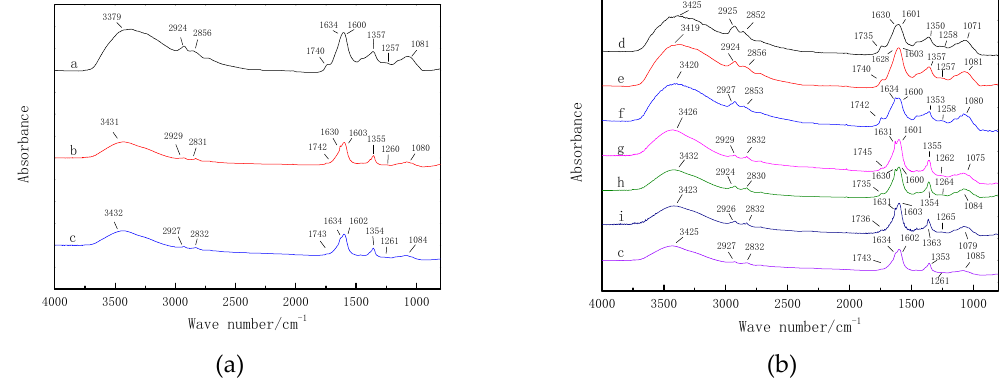
Figure 8. Infrared spectra of Chinese wolfberry fruits under ion wind and without ion wind. ( a ) Ionic wind and without ionic wind; ( b ) different needle spacing. Note: a. Ionic wind; b. Without ionic wind; c. Control; d. 2 cm; e. 4 cm; f. 6 cm; g. 8 cm; h. 10 cm; and i. 12 cm.